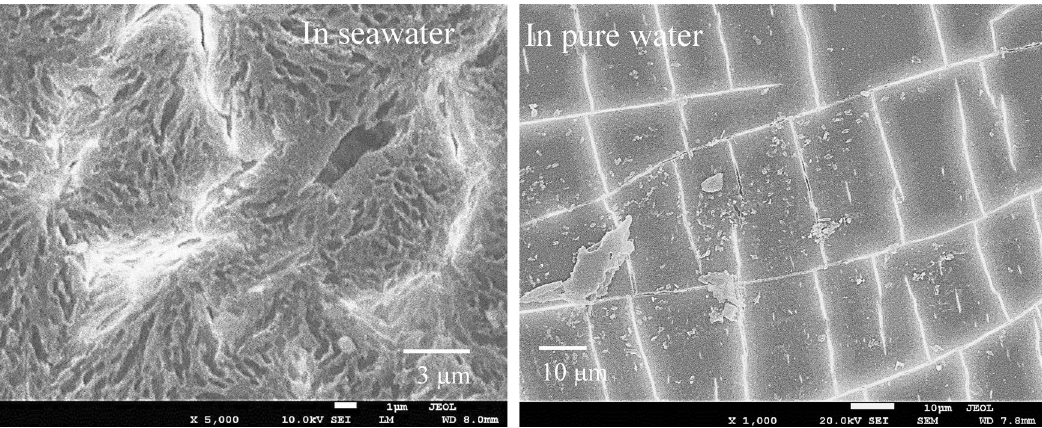
Figure 4. SEM photographs of 15 days-AOP degradation PP in seawater and distilled